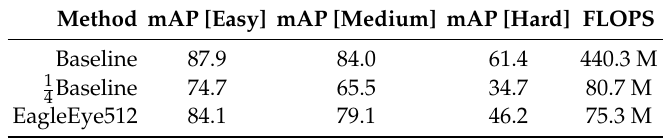
Table 5. Comparison EagleEye with directly pruning on the baseline on wider face’s validation set.